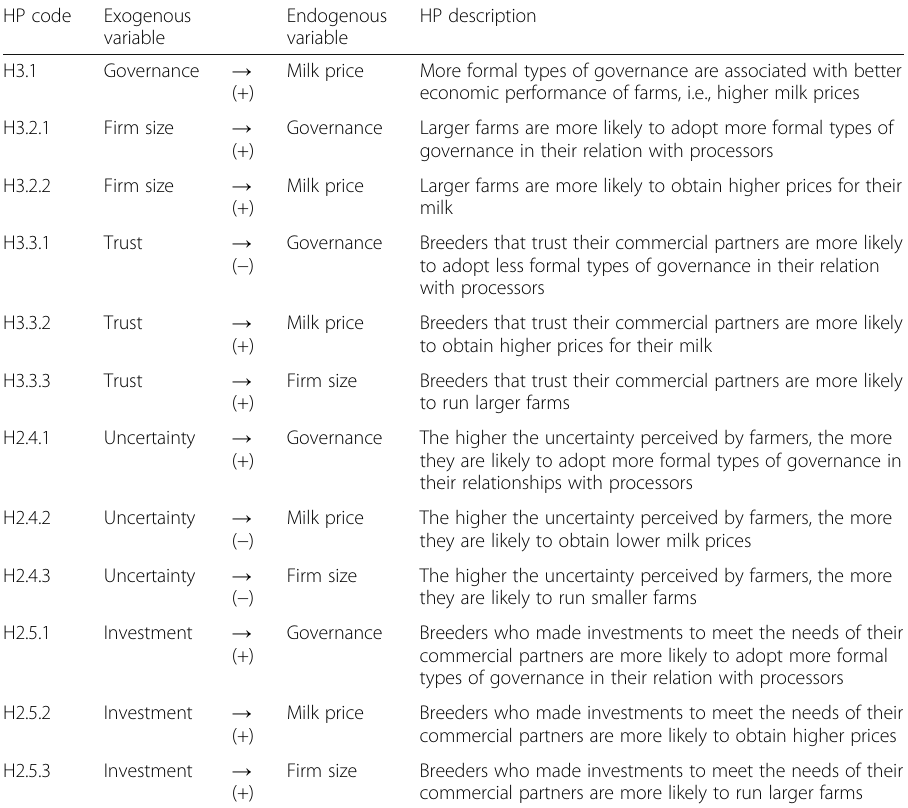
Table 3 Research hypotheses investigating the effects of producer-processor relationship characteristics on relational governance and firm economic